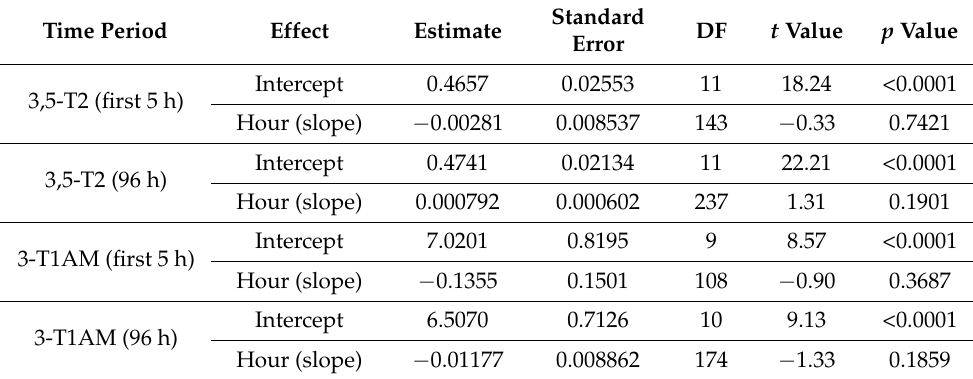
Table 1. Changes in 3,5-T2 and 3-T1AM over time in the healthy volunteers.